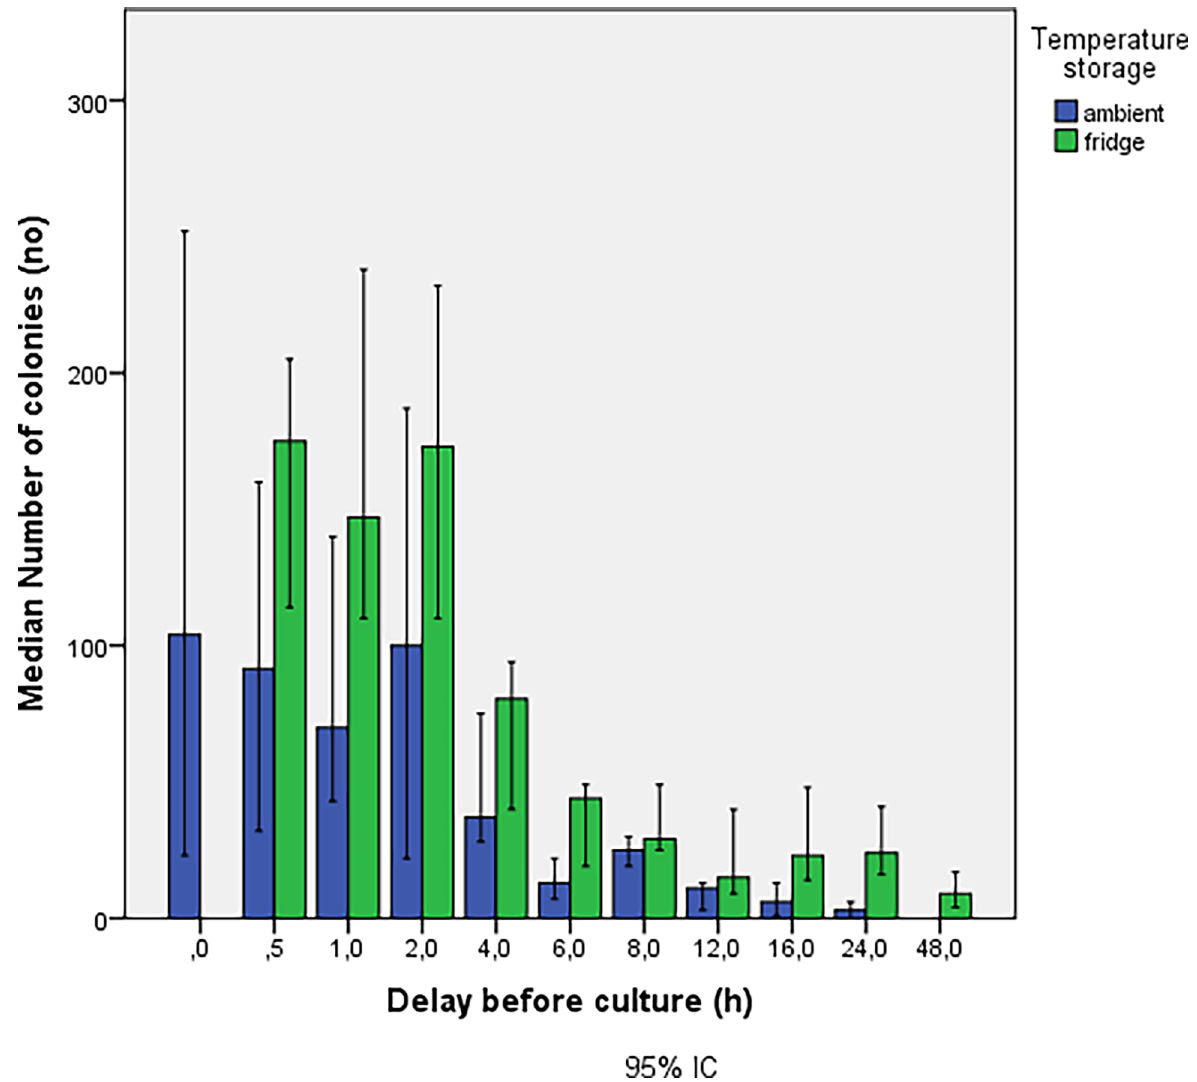
Fig 2. Results from experiments 1 and 2. In function of the storage